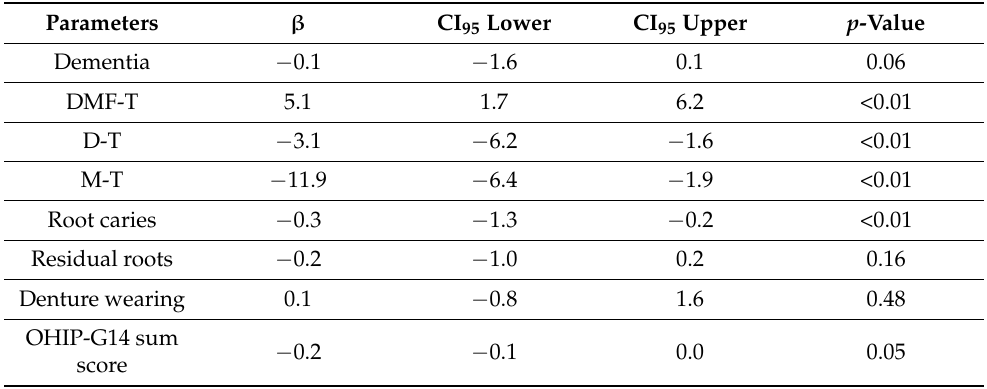
Table 5. Regression analysis of MNA as dependent variable for different independent